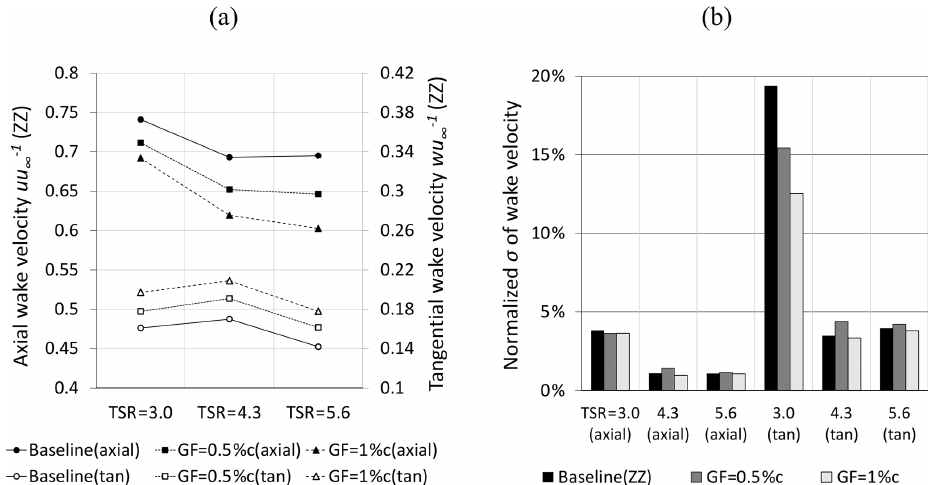
Figure 7. Tripped case at r = 0.56 R and ϕ = 270 ◦ . (a) Mean axial and tangential (tan) wake velocity normalized by the inflow velocity. (b) Standard deviation of the wake velocity normalized by the average wake velocity.